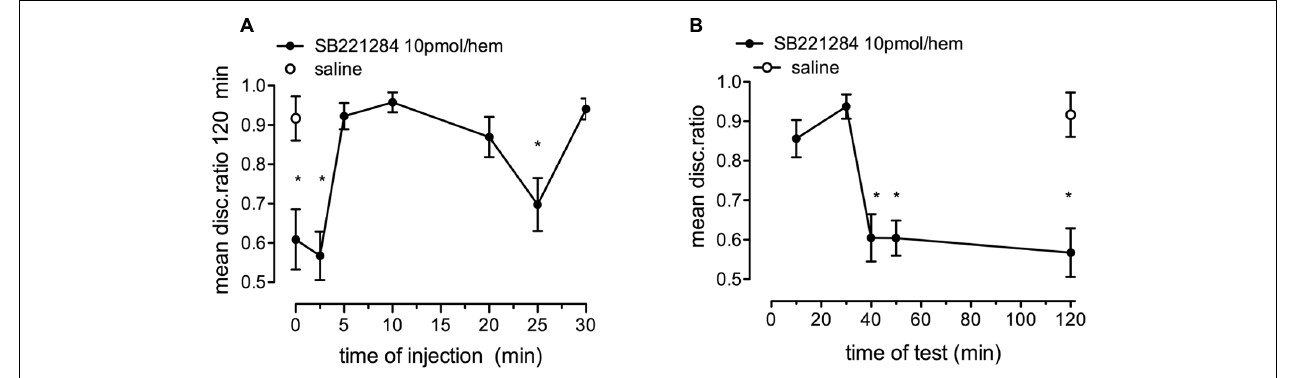
FIGURE 6 | Effect of the selective 5-HT 2B/C receptor antagonist, SB221284, on strongly reinforced memory. (A) Time of injection of 10 pmol/hem of SB221284 relative to training and tested 120 min after